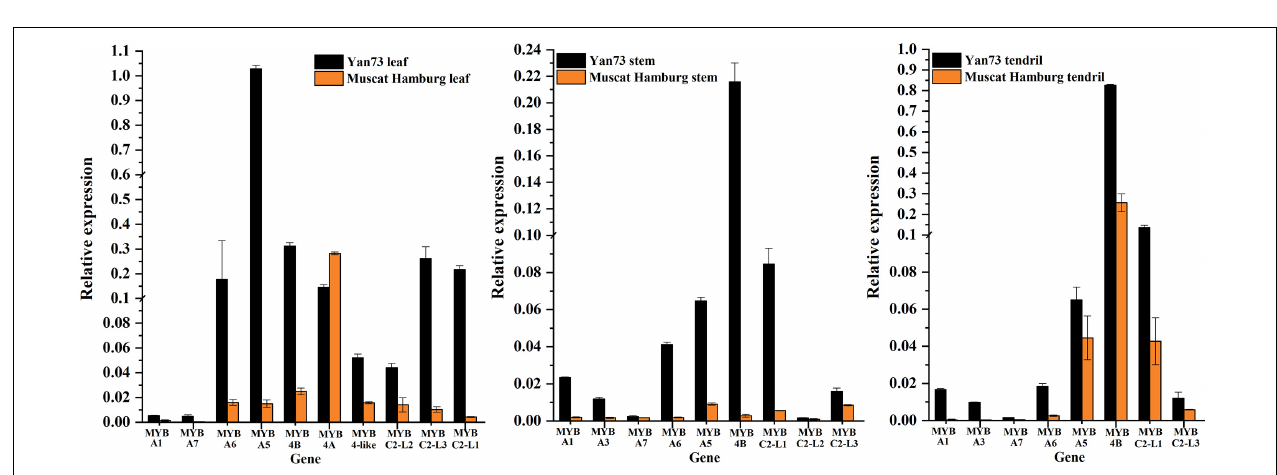
FIGURE 4 | Phylogenetic relationships among R2R3-MYB family members detected in Yan73 and its male parent leaf, stem, and tendril tissues (based on RNA-seq data) and R2R3-MYBs from other plant species. The gene IDs are listed in Supplementary Tables S2 – S5 . The up- and down-regulated transcription factors in Yan73 red leaf, stem and tendril tissues are indicated with red and green dots, respectively, and the corresponding transcript patterns are presented on two grids: the left presents the FPKM values of Yan73 leaves, stems, and tendrils, whereas the right presents the log 2 ( Yan 73 leaf , stem , tendril / Yan 73 maleparentleaf , stem , tendril ) values. The grid on the left with seven colors indicates the absolute expression levels in Yan73 red leave, stem and tendril tissues, with the FPKM values 0-2 1 , 2 1 -2 2 , 2 2 -2 3 , 2 3 -2 4 , 2 4 -2 5 , 2 5 -2 6 , and 2 6 -2 7 represented by 0-1, 1-2, 2-3, 3-4, 4-5, 5–6, and 6-7, respectively. Each functional clade is highlight.